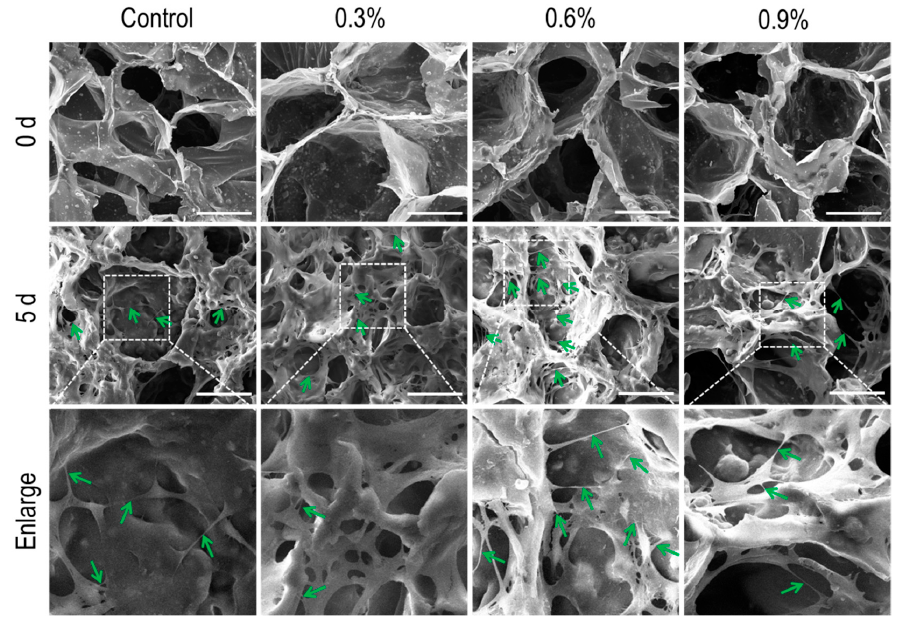
Figure 7. SEM observations of different cells-scaffold composites. The number of cells significantly increased after culture for 5 days compared to 0 days. The white dotted boxes in the middle panel were enlarged in the bottom panel. The green arrow presented the interconnection between the cells, and the interconnection density of the cells cultured on the CS/Gel/nHAp/0.6%MWCNTs scaffold was a little higher compared to other scaffolds. Scale: 100 μ m. Polymers 2018 , 10 , x FOR PEER REVIEW